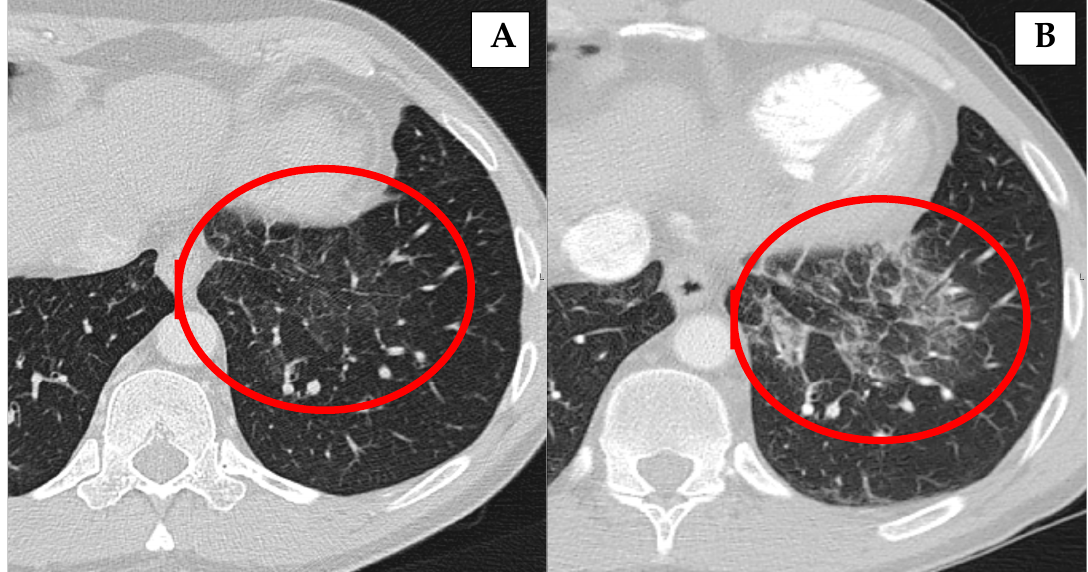
Figure 2. Inflammatory changes in the lungs ( B ) that decrease in size and disappear after corticosteroid treatment ( A ).